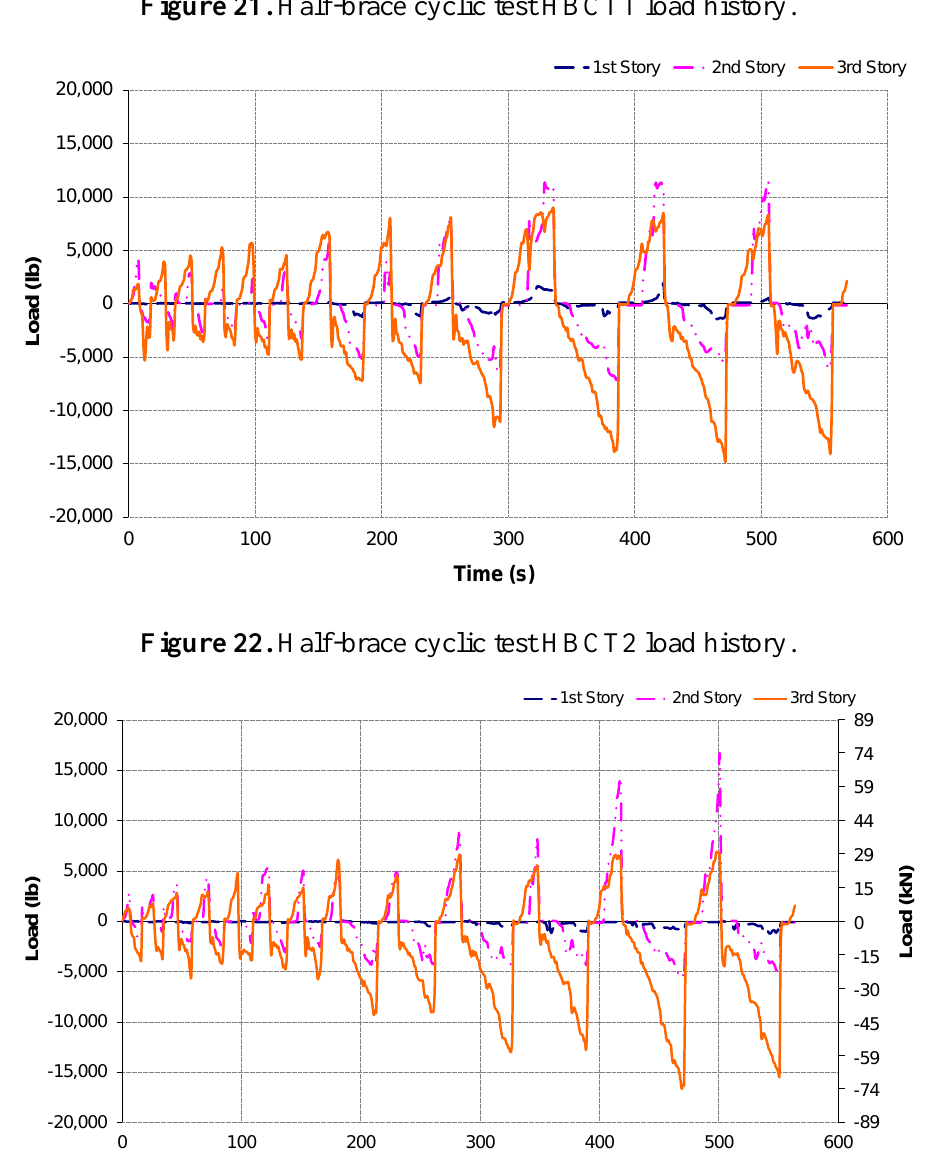
Figure 21. Half-brace cyclic test HBCT1 load history.